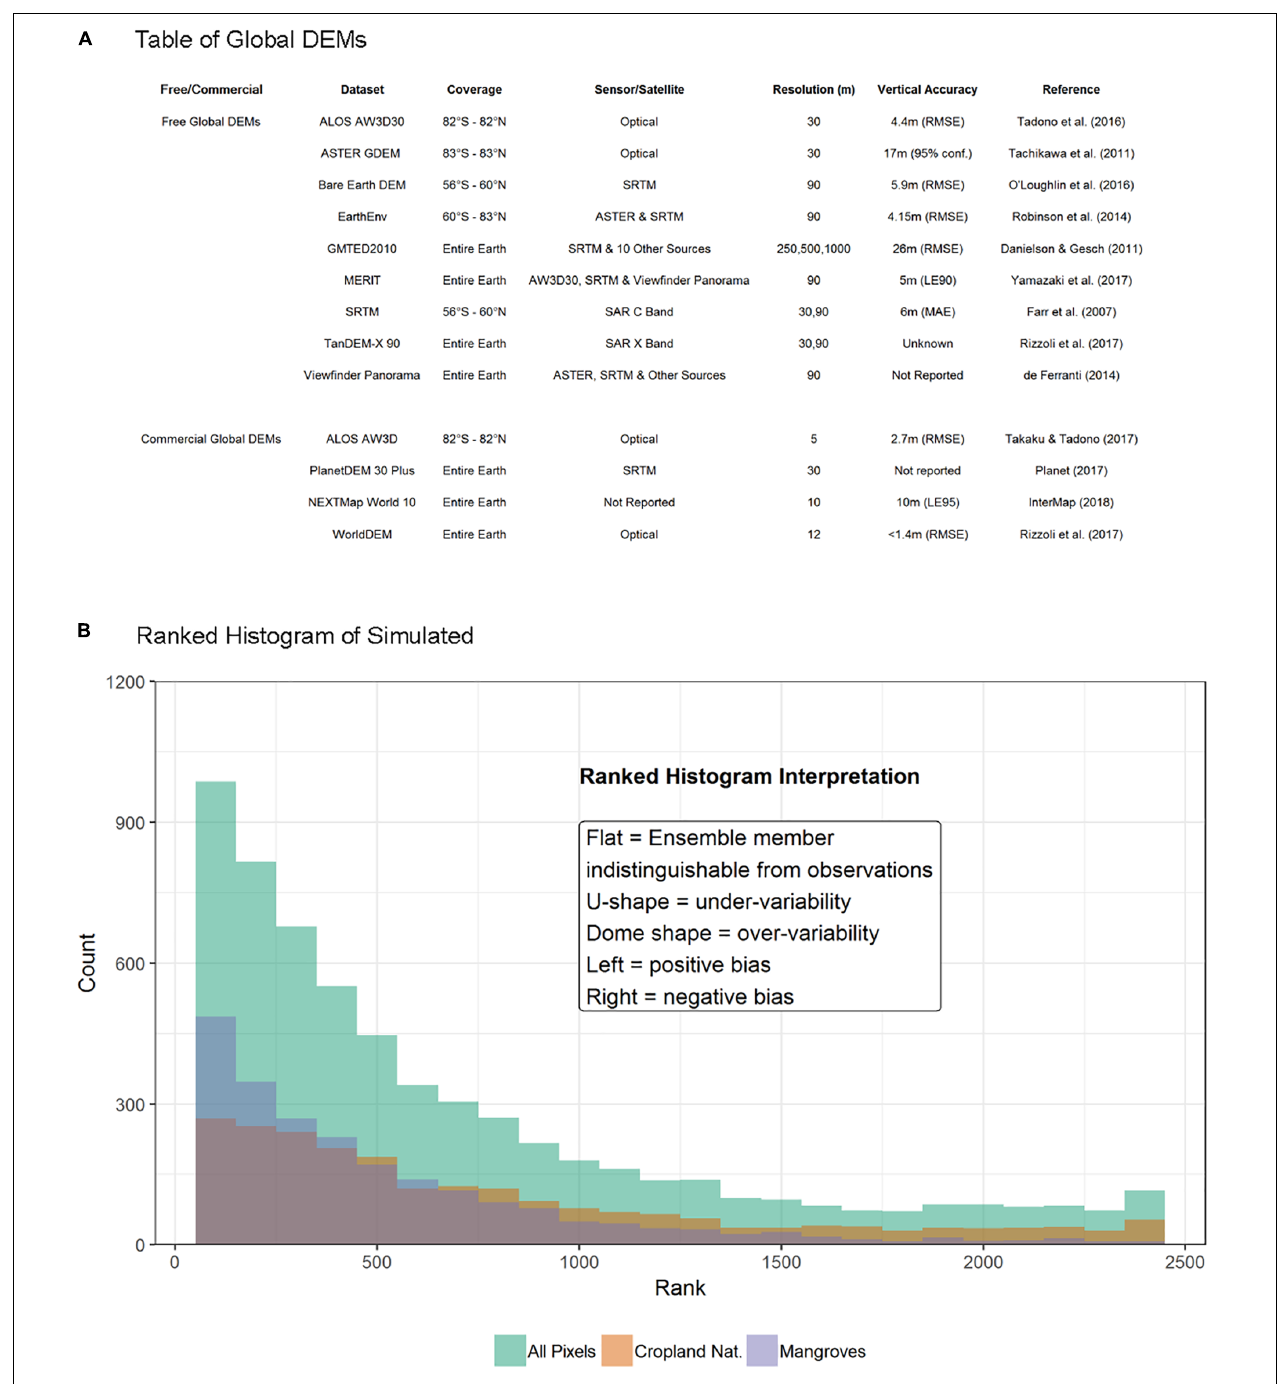
FIGURE 1 | (A) Overview of Existing Global DEMs (free and commercial). (B) Rank Histograms for an ensemble of 2500 DEMs of the Ba catchment in Fiji, simulated from the MERIT DEM using semi-variograms of spatial error structure by landcover class. All Pixels and the two landcover classes with the most pixels (Mosaic Cropland/Natural Vegetation and Mangroves) are